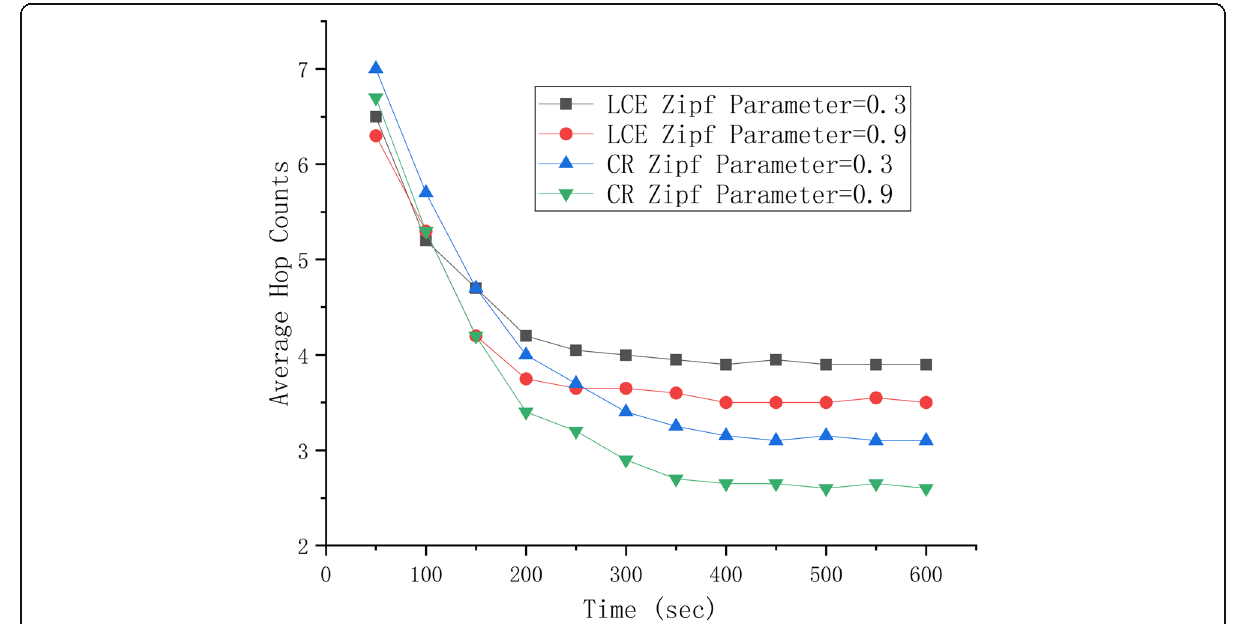
Fig. 9 Hop counts vs. time for cross regions. The results clearly show that CR outperforms LCE after they reach steady state, which is not surprising as CR takes advantage of hotspot user requirement patterns caching more popular contents in the nearby storage nodes. Note that CR takes longer time than LCE to reach stable